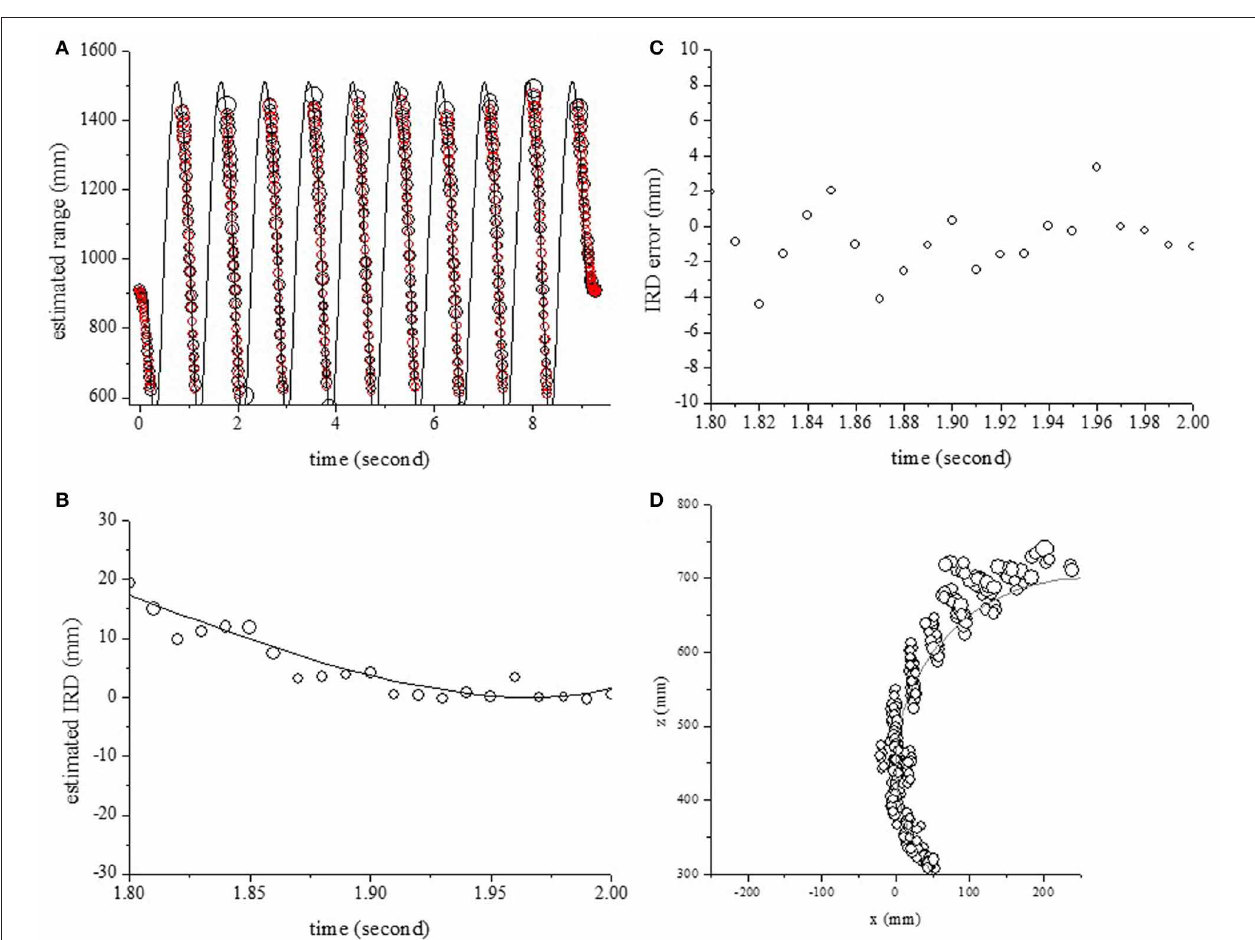
FIGURE 6 | Outputs for one object, moving back and forth with a rotation radius of 250mm. (A) Estimated and actual ranges. (B) Estimated IRDs. (C) Estimation errors of IRDs. (D) Estimated and actual positions in 2D